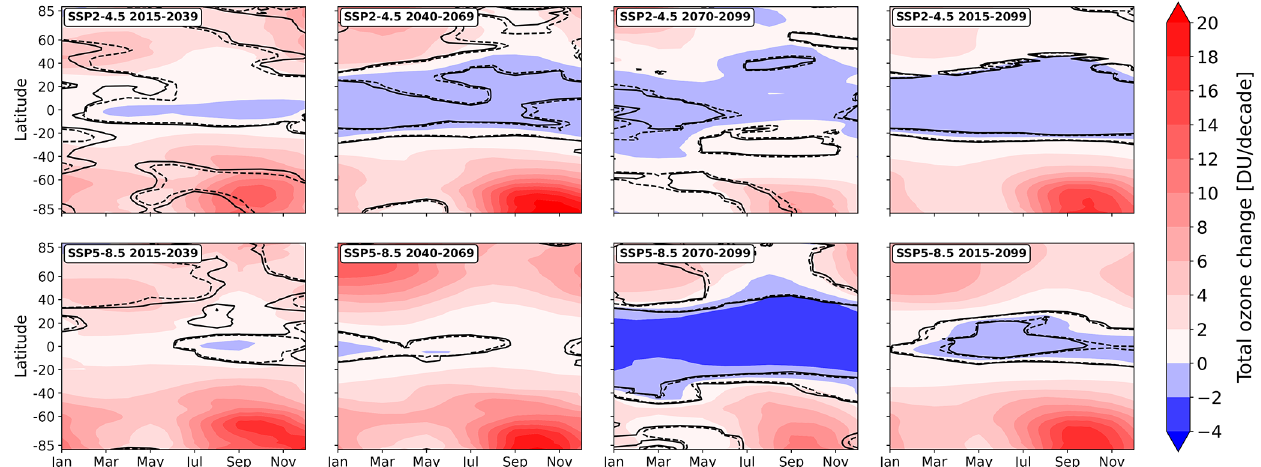
Figure 4. Trends in total column ozone as a function of month and latitude for the 2015–2099 period and different subperiods from both SSP2-4.5 and SSP5-8.5 simulations. The names of the corresponding scenario and the period are indicated in the upper left corner of each panel. The dashed line is the delimiter of the region, with significance at the 90% level for positive or negative changes; the solid line is the same at the 95%